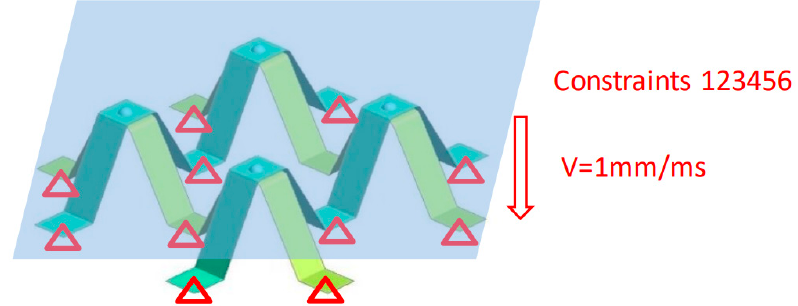
Figure 2. The quasi-static collapse simulation model of memory alloy combination single layer module.